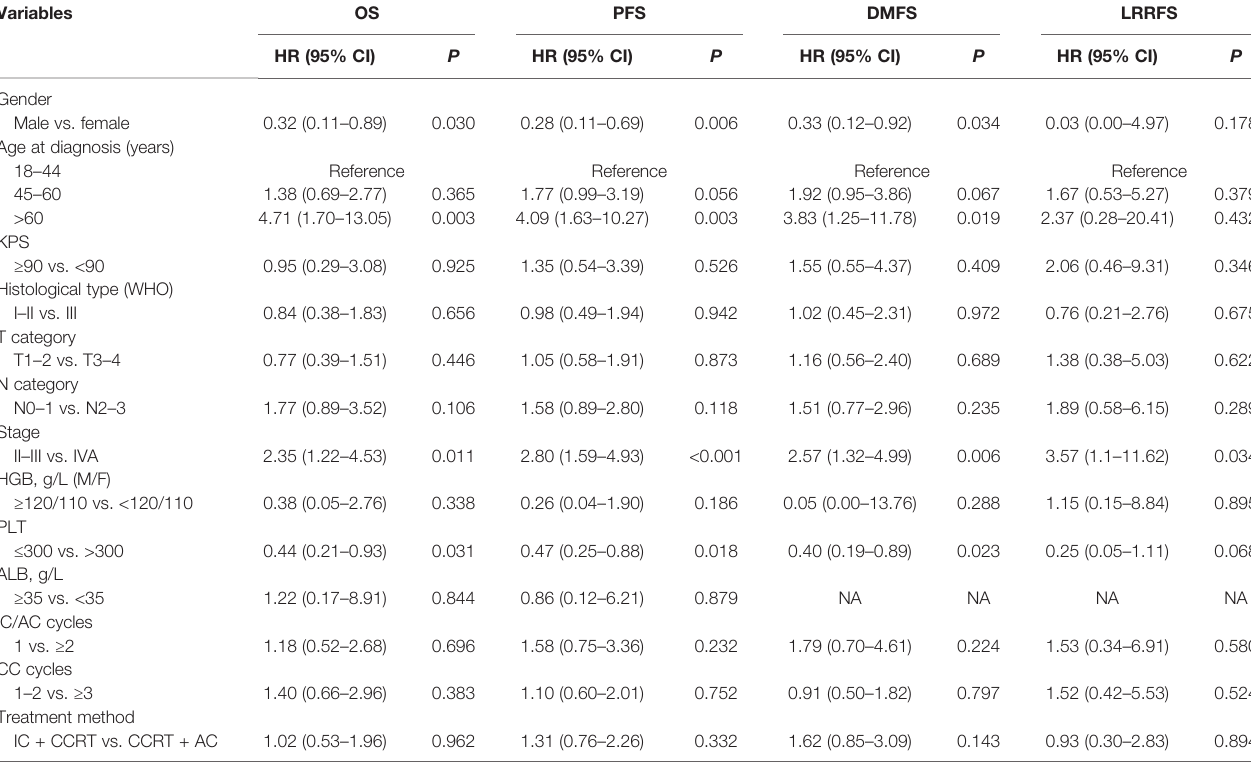
TABLE 2 | Univariate Cox analysis of prognostic factors for NPC patients after PSM. Variables